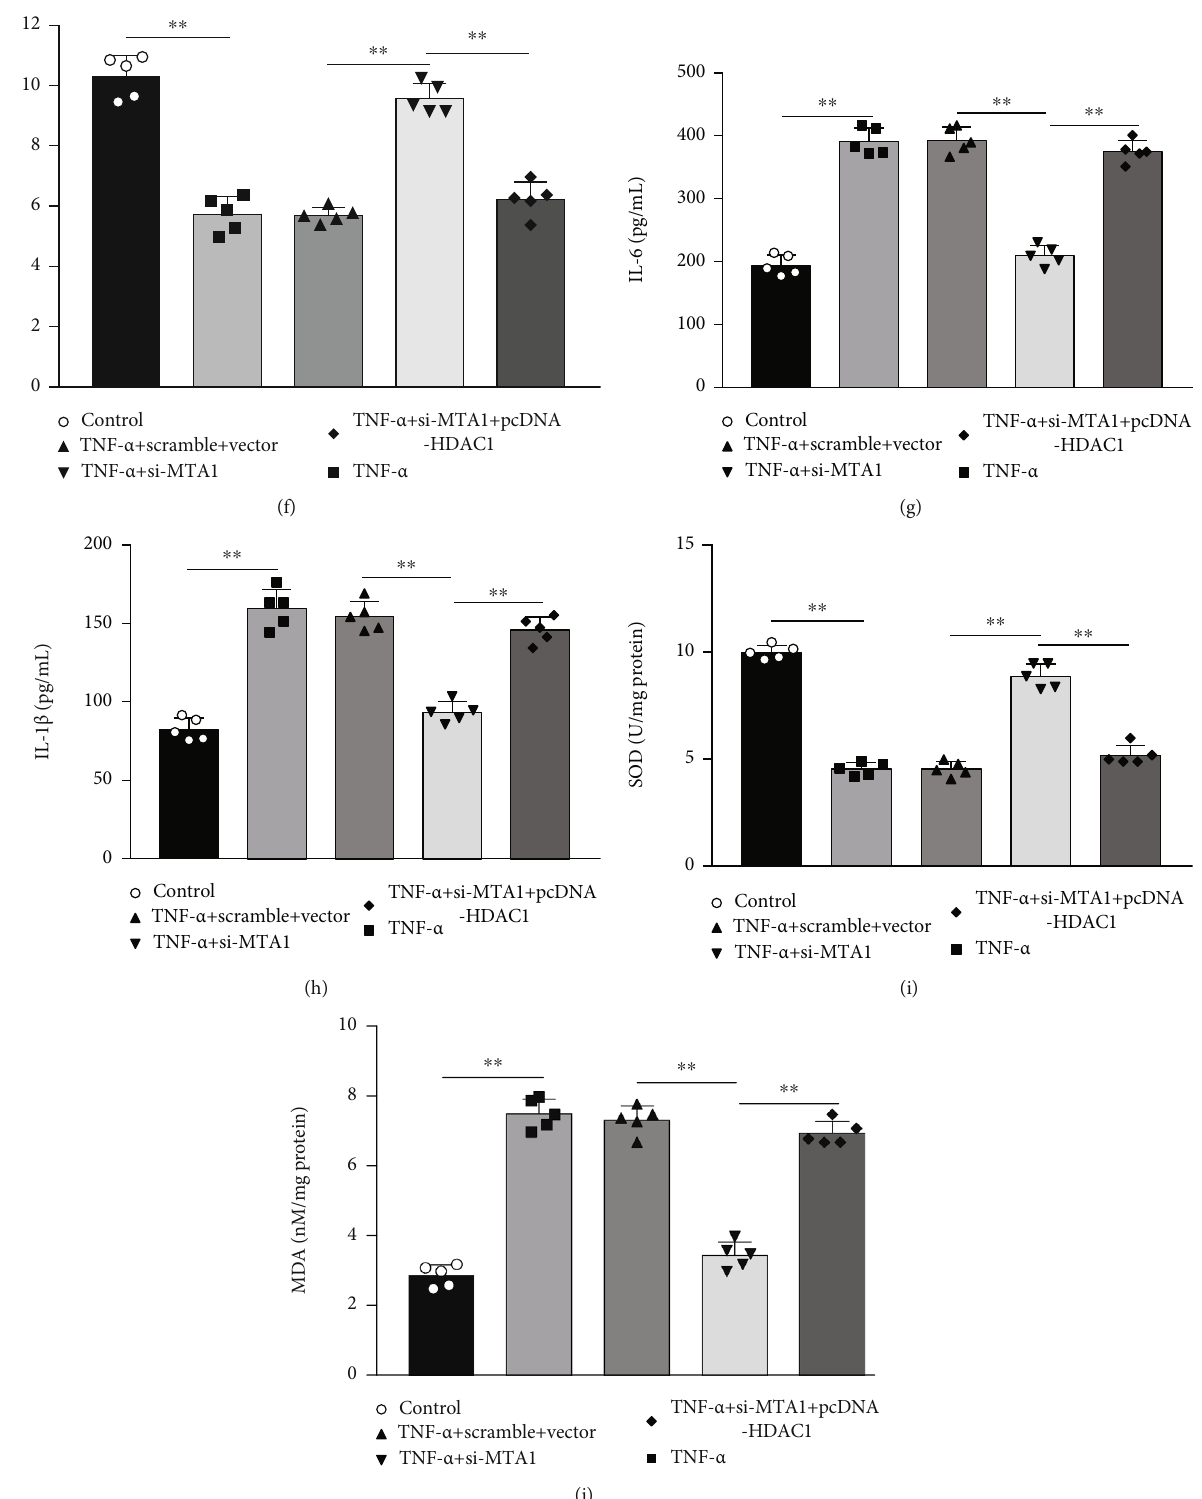
Figure 4: MTA1 knockdown inhibited proliferation, in fl ammation, and oxidative stress and promoted apoptosis by downregulating HDAC1 in MH7A cells. TNF- α -treated MH7A cells were transfected with si-MTA1 alone or together with pcDNA-HDAC1. (a – c) The protein expression of MTA1 and HDAC1 was detected by Western blot analysis. (d) MH7A cell proliferation was measured by CCK-8 assay. (e, f) Flow cytometry was performed to measure MH7A cell apoptosis. (g, h) The levels of IL-6 and IL-1 β in cell culture supernatant were detected by ELISA. (i, j) The levels of SOD and MDA in MH7A cells were examined by commercial kits. Data from at least three replicate experiments were presented as mean ± SD . N = 5 . ∗∗ P < 0 : 01